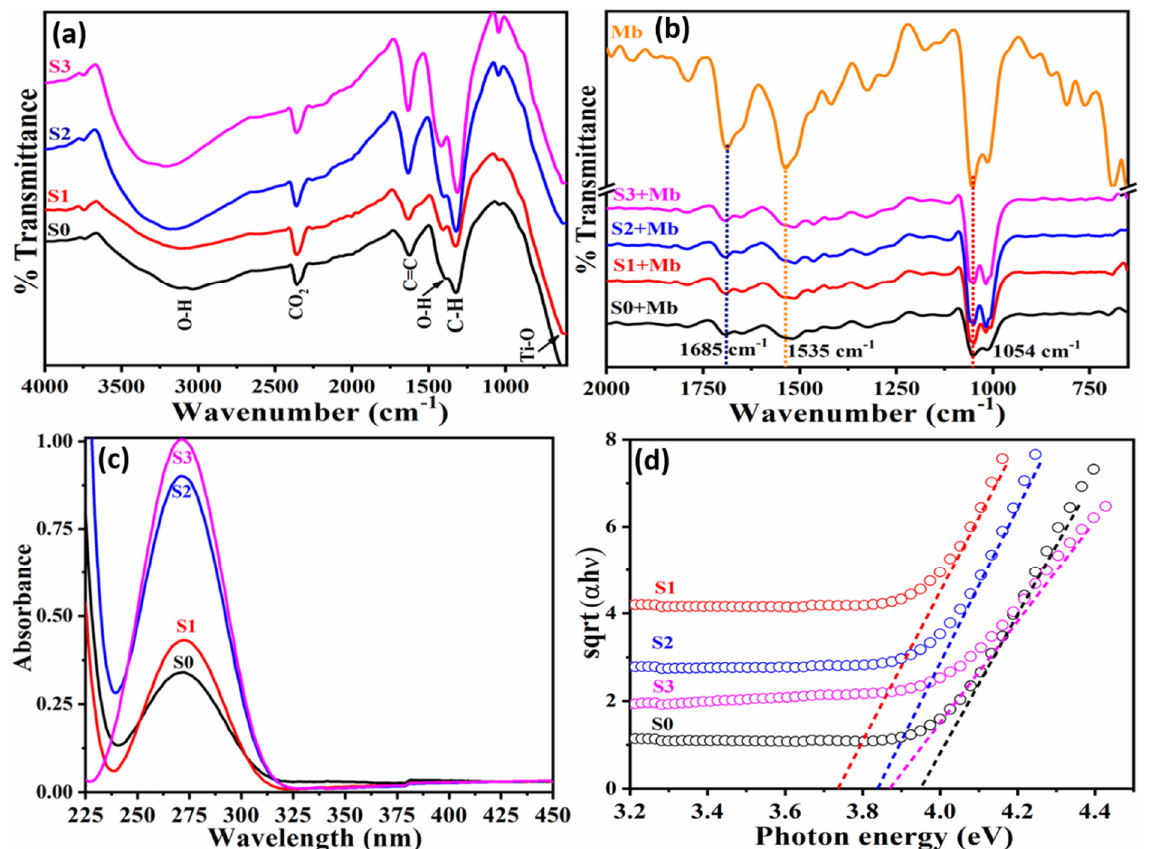
Figure 3. Typical FTIR spectra for the ( a ) as-synthesized materials and ( b ) materials interactions with Mb, ( c ) UV-Vis absorption spectra and ( d ) Tauc’s plot of undoped and Mn doped TiO 2 nanoparticles [S0 = pristine Mn (13 × 10 17 Mn atoms/cm 3 ); S2 = TiO 2 − Mn (20 × 10 17 Mn atoms/cm 3 ); S3 = TiO 2 − Mn (32 × 10 17 Mn atoms/cm 3 )].